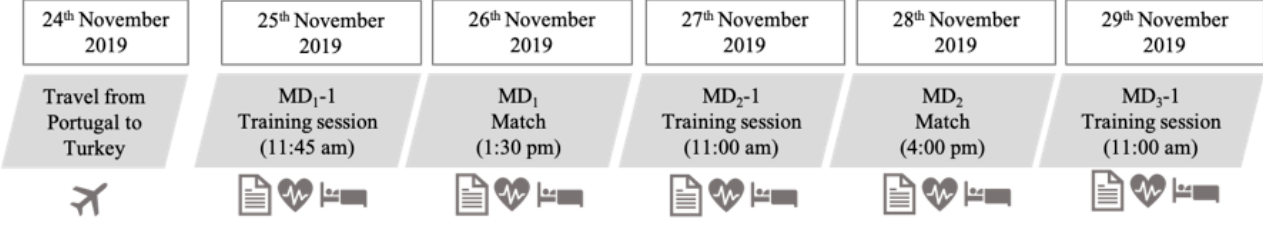
Figure 1. Schematic showing the study design. Session-rating of perceived exertion included training and match days. During night-sleep of the 5 days, cardiac autonomic activity and sleep characteristics were assessed using heart rate monitors and accelerometers, respectively.